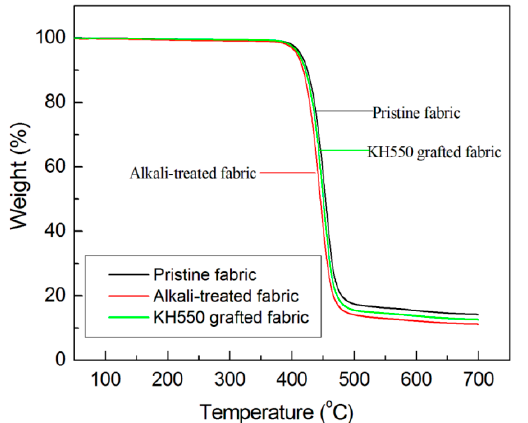
Figure 6. FTIR spectrum analysis of the fabric modified by different process modes. ( a ) wide scan spectra of FTIR; ( b ) FTIR spectrum with wavenumbers from 1300 cm − 1 to 1100 cm − 1 .